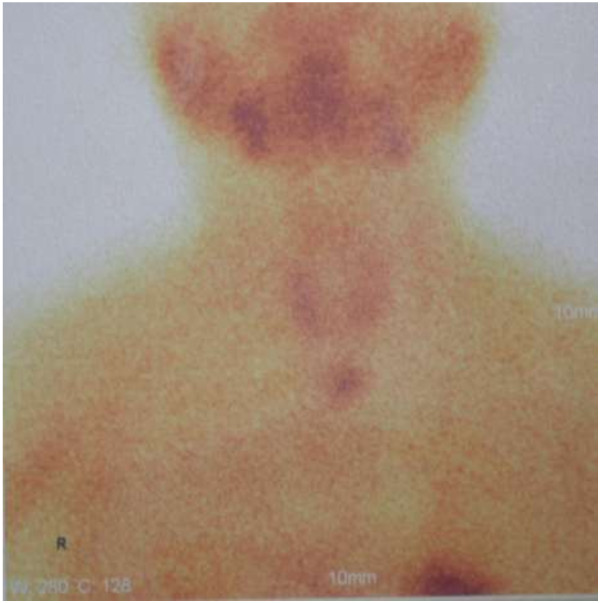
The 5
th
parathyroid gland was confirmed by positive sestamibi
99 m
Tc investigation in the mediastinum in 1 year after the surgery.